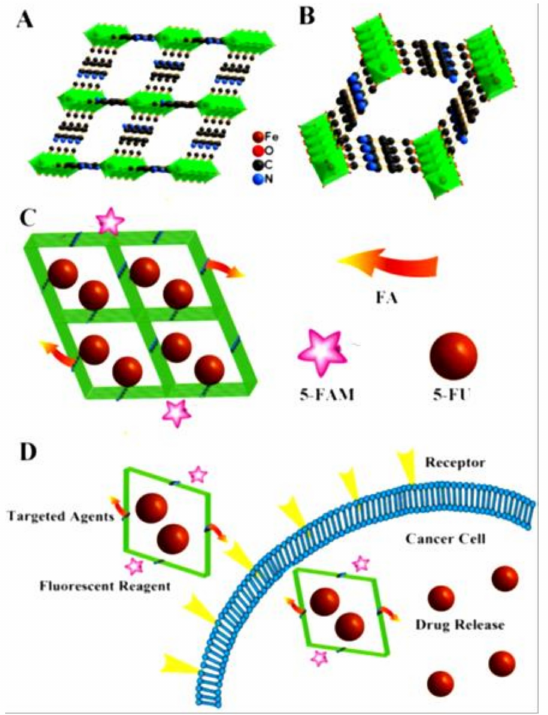
Figure 9. 2D plane view of Fe-MIL-53-NH 2 ( A , B ), schematic representation of the drug delivery system Fe-MIL-53-NH 2 -FA-5-FAM/5-FU ( C ), and schematic illustrations of Fe-MIL-53-NH 2 -FA- 5-FAM/5-FU for targeting drug delivery ( D ). Reprinted with permission from ACS Appl. Mater. Interfaces 2017, 9, 3455–3462 ([250]). Copyright 2017 American Chemical